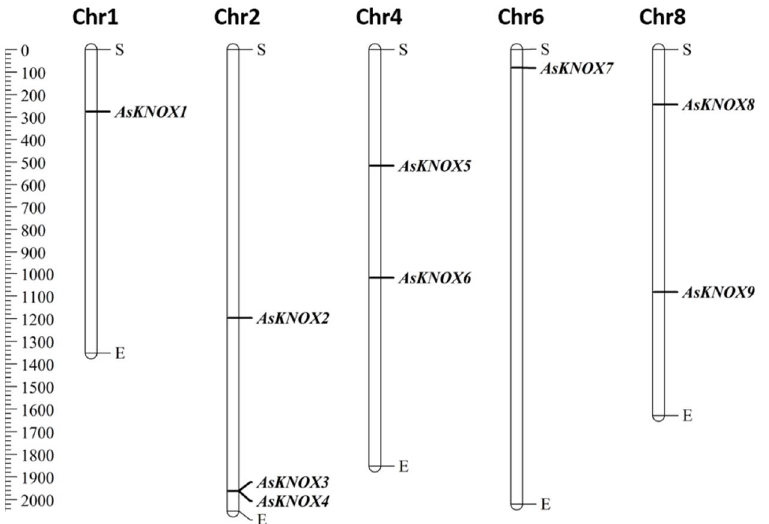
Figure 1. Distribution of AsKNOX genes on garlic chromosomes. The left scale represents the length of garlic chromosomes with a unit of Megabase pairs (Mb). The letters of S and E indicate the start and end positions of each chromosome.